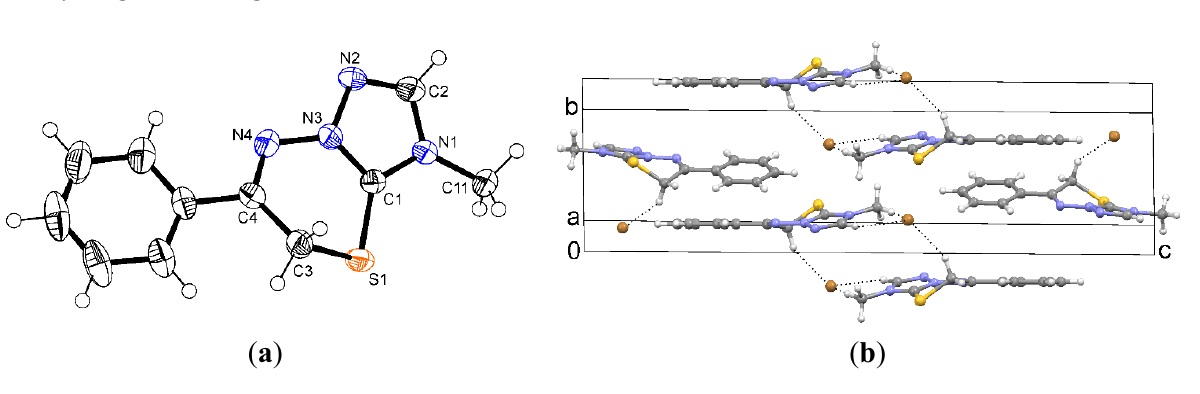
Figure 4. ( a ) O RTEP plot and atom numbering scheme of the cation; ( b ) packing and hydrogen bonding of 3